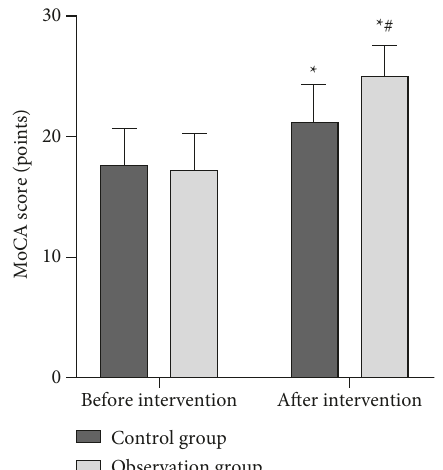
Figure 4: Comparison of daily living ability between two groups. Compared with before